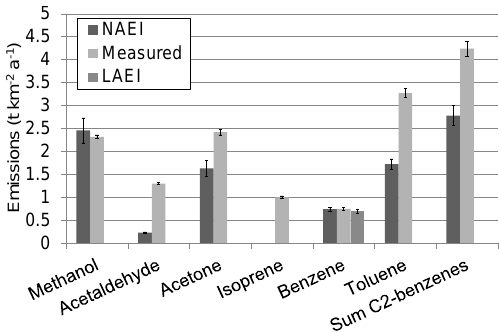
Figure 10. Bar chart showing scaled comparisons of LAEI and NAEI estimates against measured fluxes in tkm − 2 a − 1 for speci- ated VOCs with error